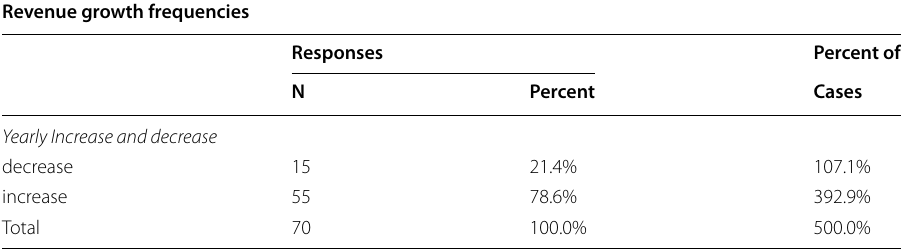
Table 10 Revenue